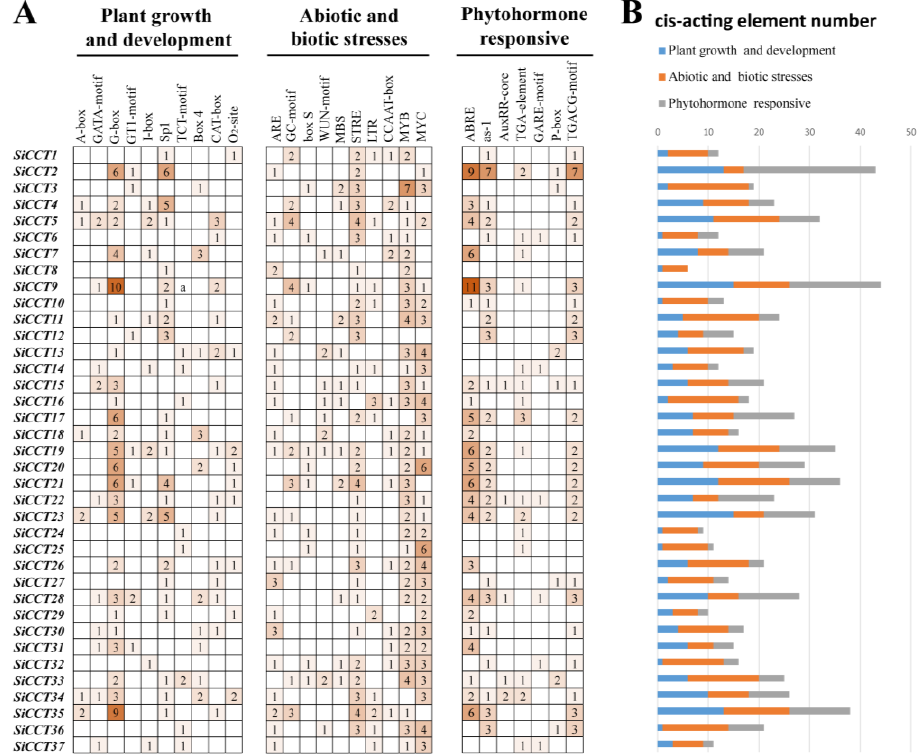
Figure 6. Cis -acting element analysis of the CCT gene family in foxtail millet. ( A ) Number of different promoter elements in the CCT genes indicated by different colors and numbers. ( B ) Number of cis -acting elements in three functional categories.